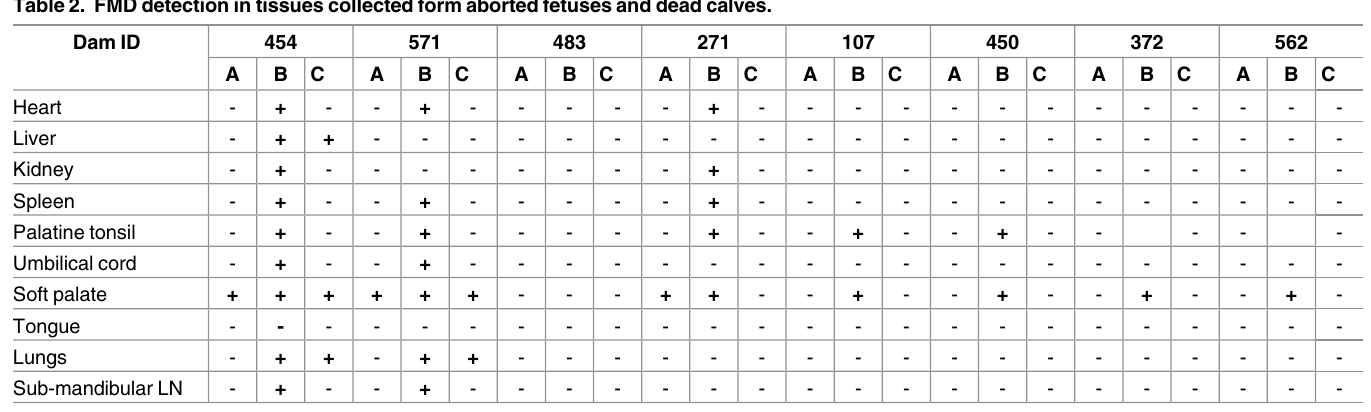
lymph node in any of the examined cases.